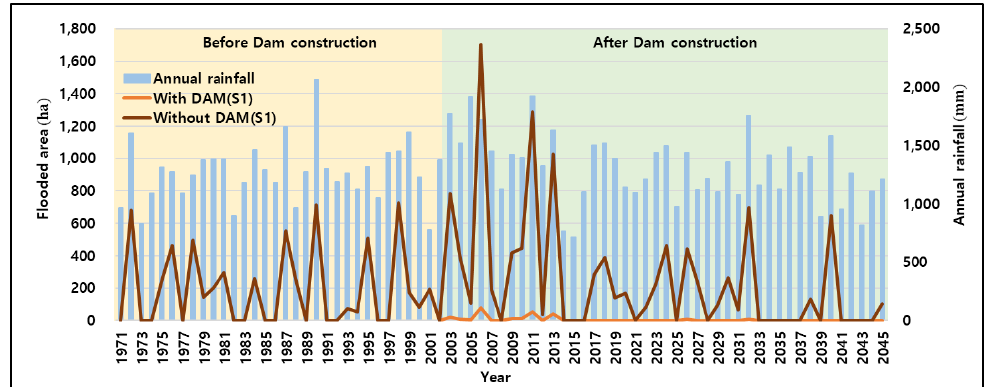
Figure 12. Flooded area comparison between the With DAM and Without DAM simulations for Scenario 1.